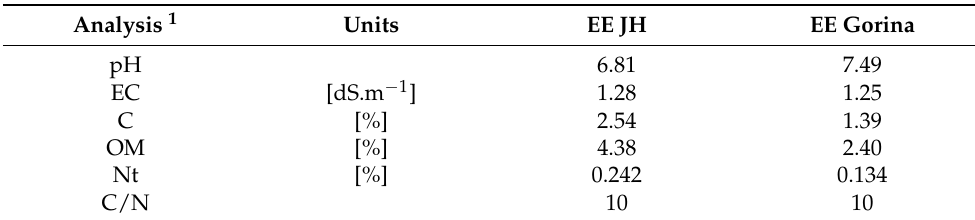
Table 3. Chemical analysis of soil from Julio Hirschhorn (EE JH) and Gorina (EE Gorina) experimental